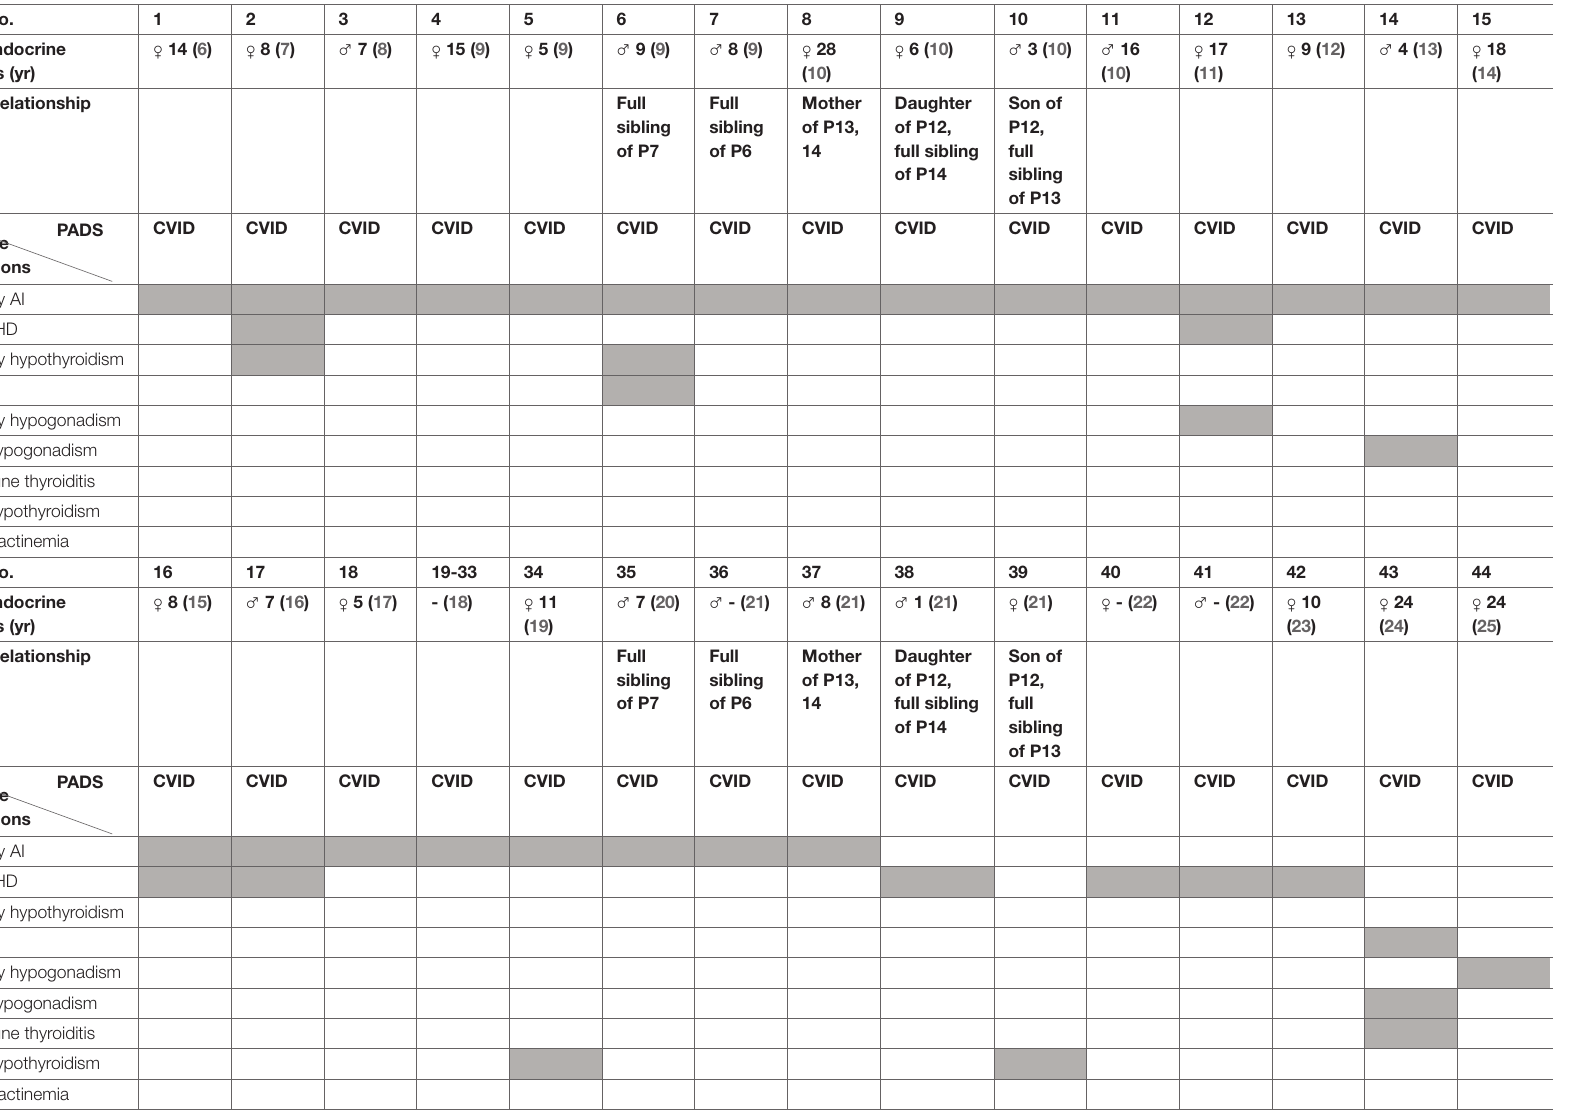
This table summarized anterior pituitary and end-organ endocrine dysfunction in CVID patients described in literature (6–25). AI, adrenal insufficiency; GHD, growth hormone deficiency; yr,